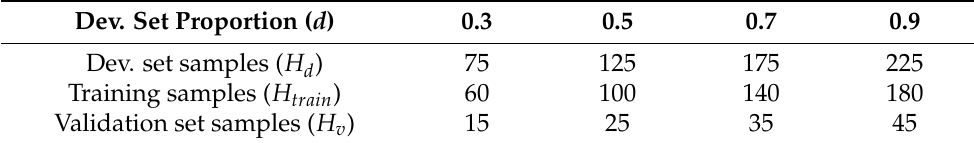
Table 3. Samples per user for development, training, and validation sets, based on d . In the case of one-day enrollment, it also represents the number of samples extracted from one visit, D1V1. In the case of two-days enrollment, the results could vary in one sample and are formed by data in D1V1 and D2V1 in the same